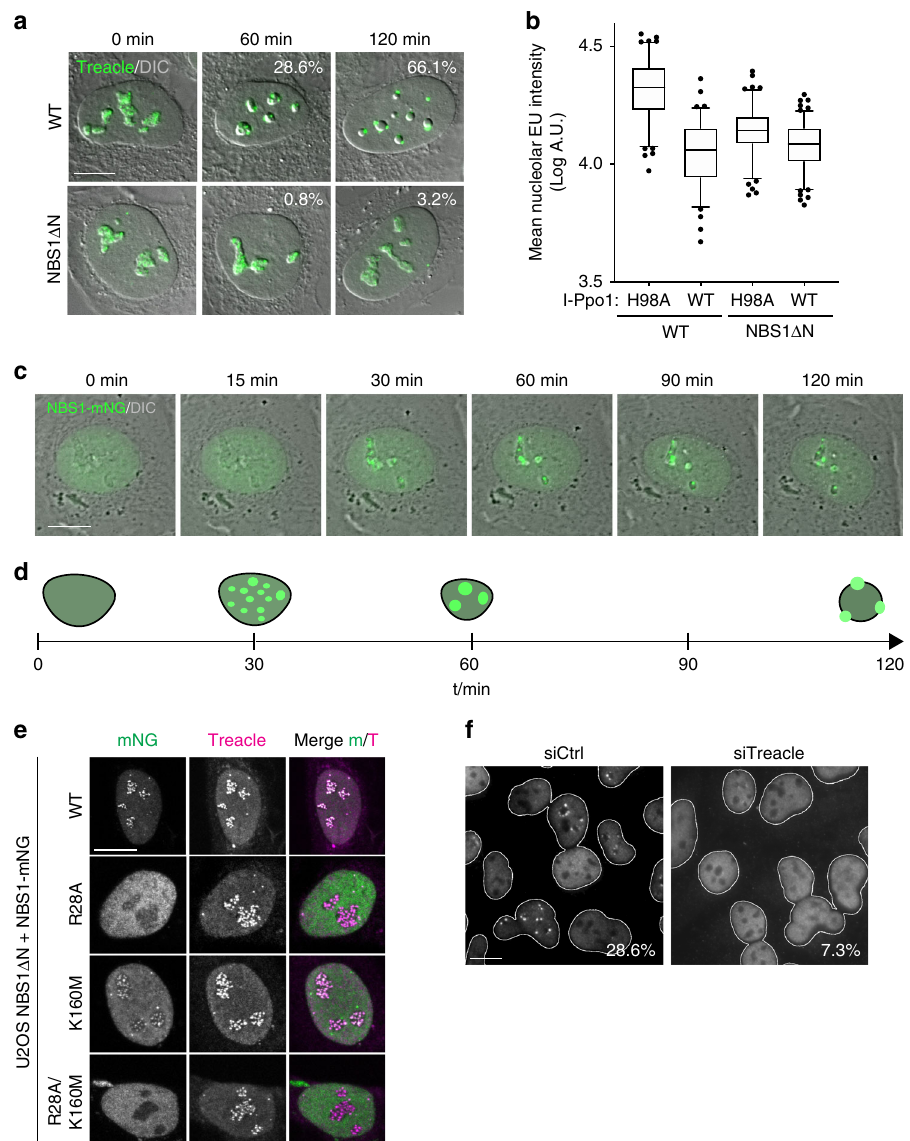
Fig. 2 NBS1 regulates the nucleolar response to rDNA breaks. a Timecourse of endogenous Treacle localization after I-Ppo1 transfection in normal U2OS cells and NBS1 Δ N cells. b Quanti fi cation of nucleolar EU incorporation after I-Ppo1 H98A ( n = 111) and I-Ppo1 WT ( n = 87) transfection in control U2OS and after I-Ppo1 H98A ( n = 116) and I-Ppo1 WT ( n = 124) transfection in NBS1 Δ N cells (boxes represent the 25 – 75 percentile range with median and whiskers represent the 5 – 95 percentile range. Data points outside of this range are shown individually). c Time-lapse microscopy of U2OS cells expressing mNG-tagged full-length NBS1 (wild type), after transfection with I-Ppo1. d Timeline of NBS1-mNG recruitment in relation to morphological changes in the nucleoli after I-Ppo1 transfection. e Confocal microscopy of NBS1-mNG wild type and point mutants in the NBS1 Δ N background. f Localization of endogenous NBS1 2 h after I-Ppo1 transfection in siCtrl and siTreacle-treated cells (percentages of cells with >2 NBS1 caps are indicated; one of two experiments is shown). All scalebars = 10 µ m. Source data are provided as a Source Data fi